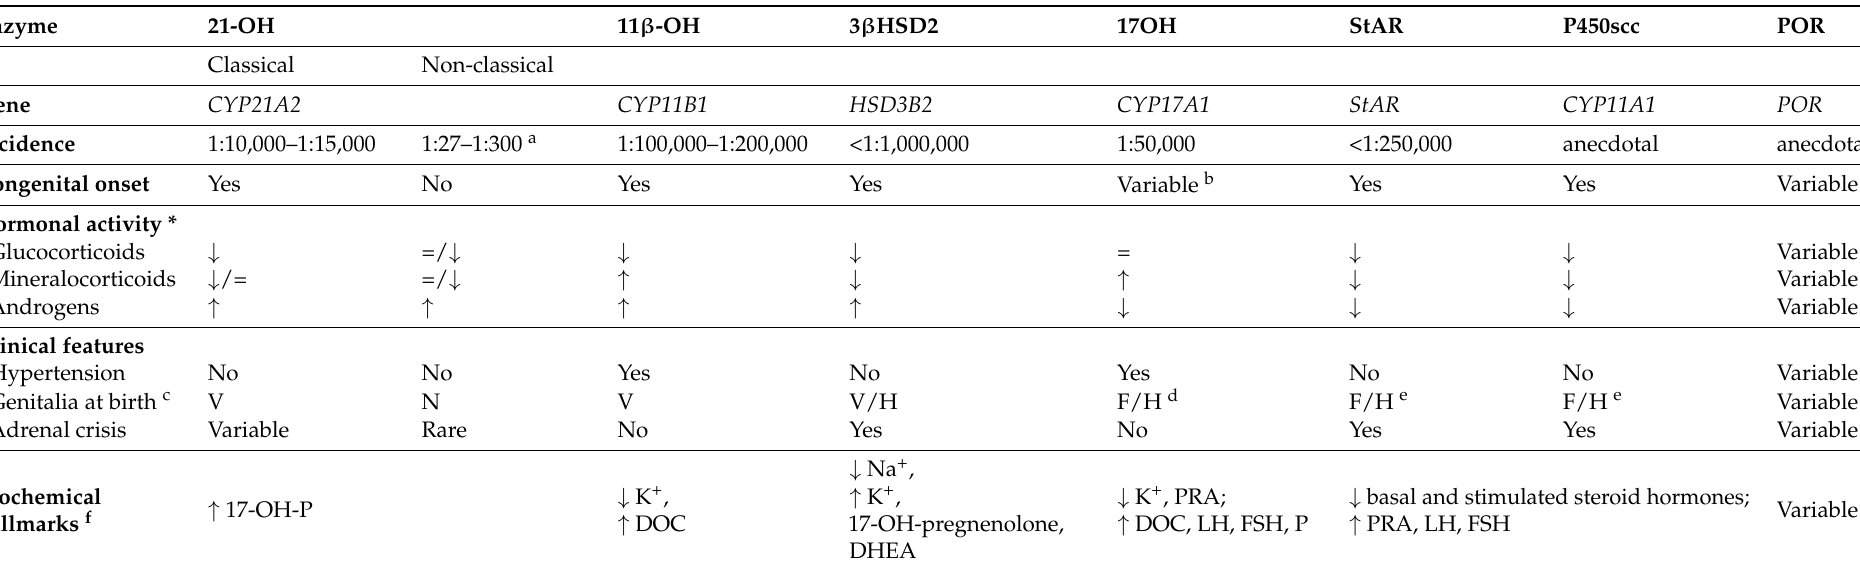
Table 1. Genetic, clinical, and laboratory features of